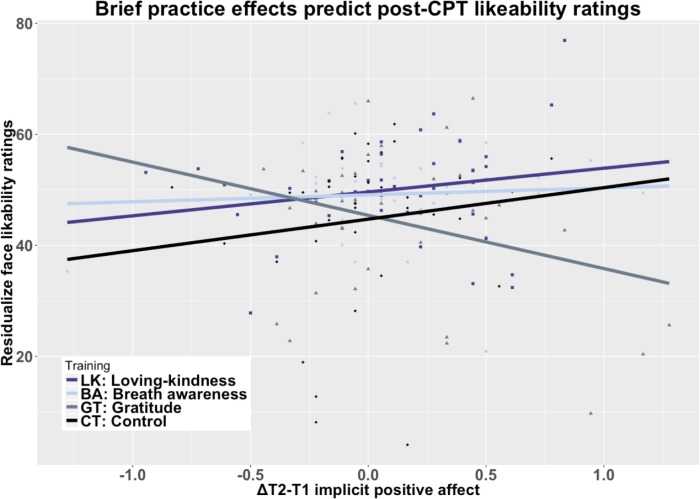
Practice induced positive affect x GROUP interaction predicts stressor-related negative affect.Notes: Explicit positive affect following practice in GT predicts stressor-induced increases in negative affect whereas in BA practice-related explicit positive affect gains are protective against stressor-induced negative affect t(68) = 3.50, p < .002, d = 0.81 CI[.33, 1.29] (corrected).